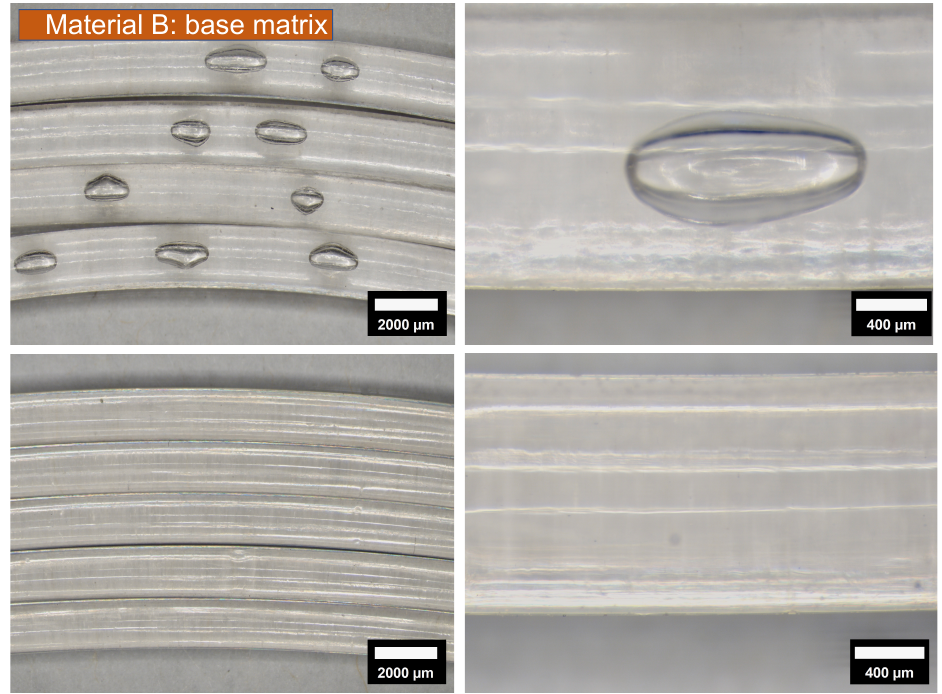
Figure 9. Microscopic images of base-matrix material B filament, PLA 6302D. Top: challenge such as voids and unmelted polymer during filament production. Bottom: good quality